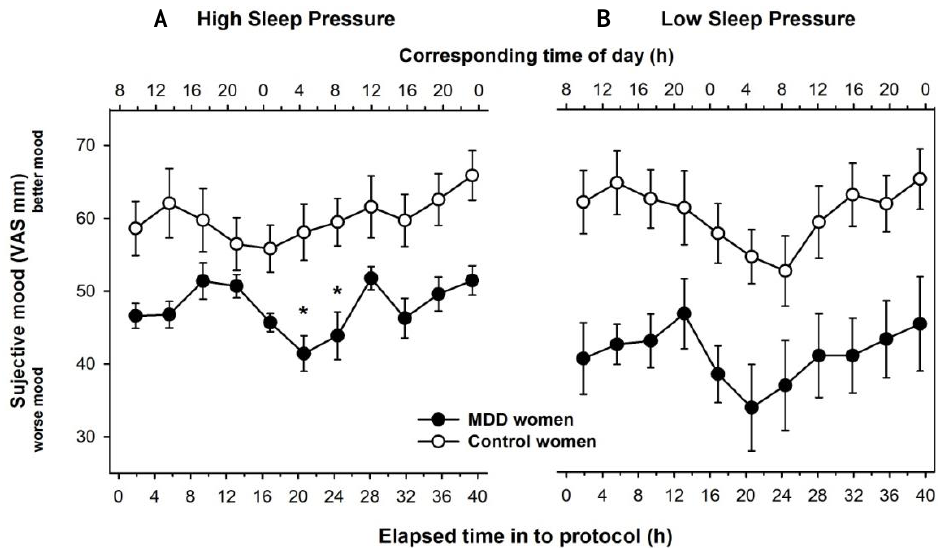
Figure 2. Time-course of subjective mood derived from the visual analogue scale during the 40-h high sleep pressure SD protocol ( A ) and during the 40-h low sleep pressure NAP protocol ( B ). Mean values ± SEM ( n = 8 for controls and n = 16 for depressed, out of which n = 8 were assigned per sleep pressure condition). Data for MDD and control women are plotted in filled black and open symbols, respectively. Asterisks indicate significant post-hoc comparisons (Differences least squares mean values, p < 0.05).